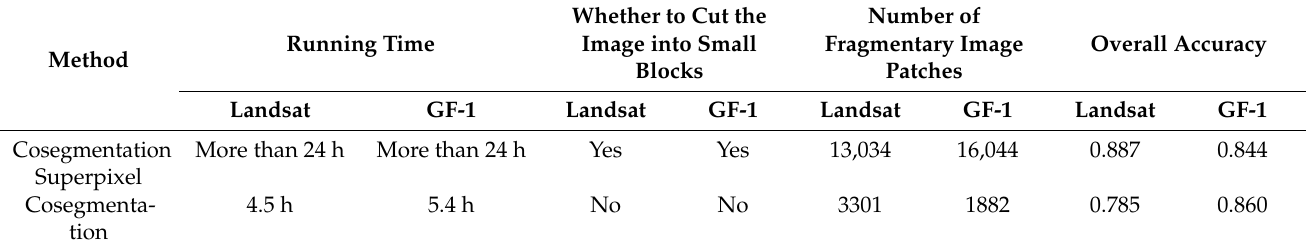
Table 9. Comparison of efficiency based on cosegmentation and pixel-based change detection.